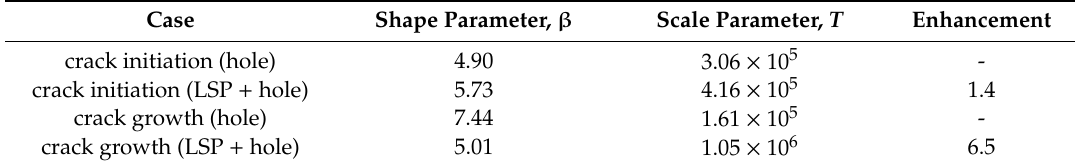
Figure 10. E ff ect of LSP on the crack initiation and crack growth periods of the fatigue life. The blue line corresponds to the number of cycles for the crack nucleation in the specimens without LSP, the red line corresponds to the number of cycles for the crack growth (from nucleation until failure) in the specimens without LSP, the green line corresponds to the number of cycles for the crack nucleation in the specimens with LSP, and the black line corresponds to the number of cycles for the crack growth in the specimens with LSP. The blue arrow represents the positive e ff ect of LSP on the fatigue behavior of the specimens regarding the fatigue crack initiation, and the red arrow represents the positive e ff ect of LSP on the fatigue behavior of the specimens regarding the fatigue crack growth. Table 3. Weibull parameters for the estimation of the e ff ect of LSP on fatigue life periods.